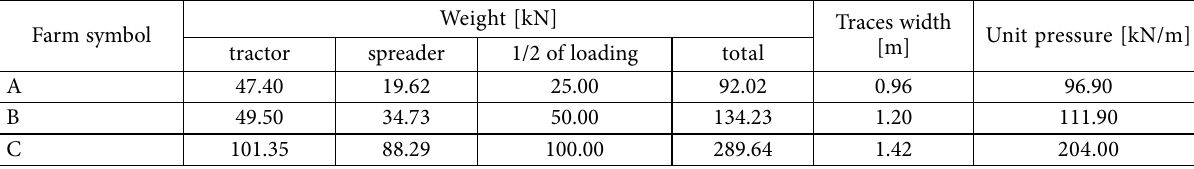
Table 8. Rolling resistance of manure spreaders